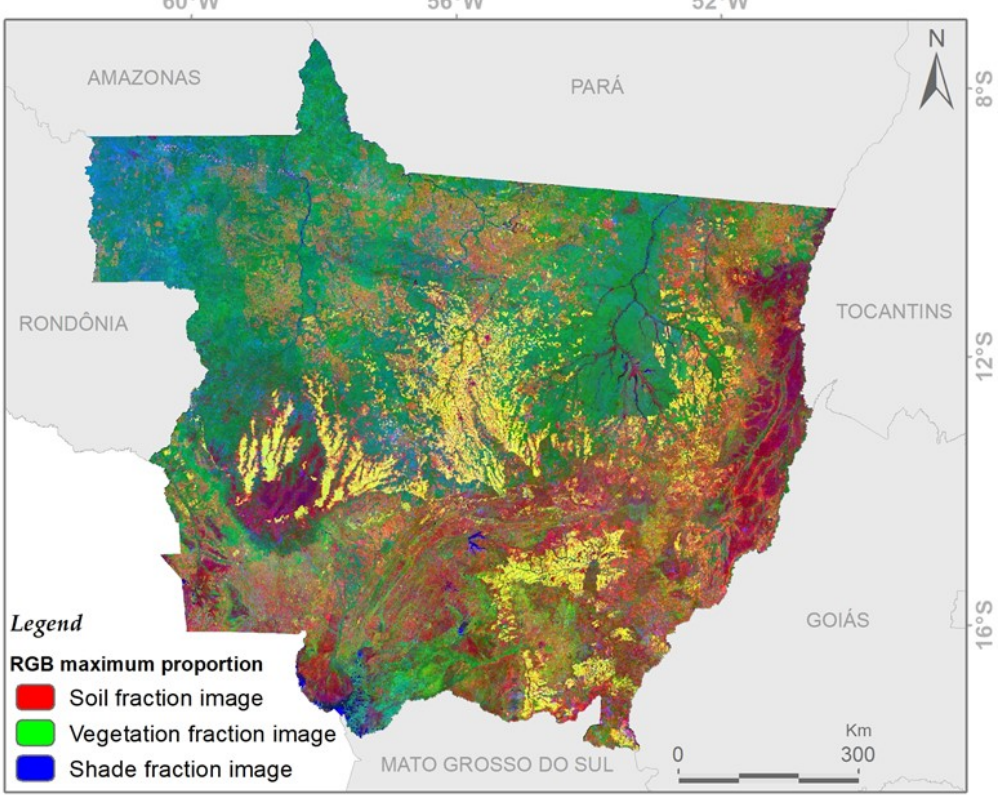
Figure 7. RGB color composite of the maximum soil, vegetation, and shade proportions derived from fraction images of Mato Grosso state. Cropland is highlighted in yellow, and forestland is highlighted in green.